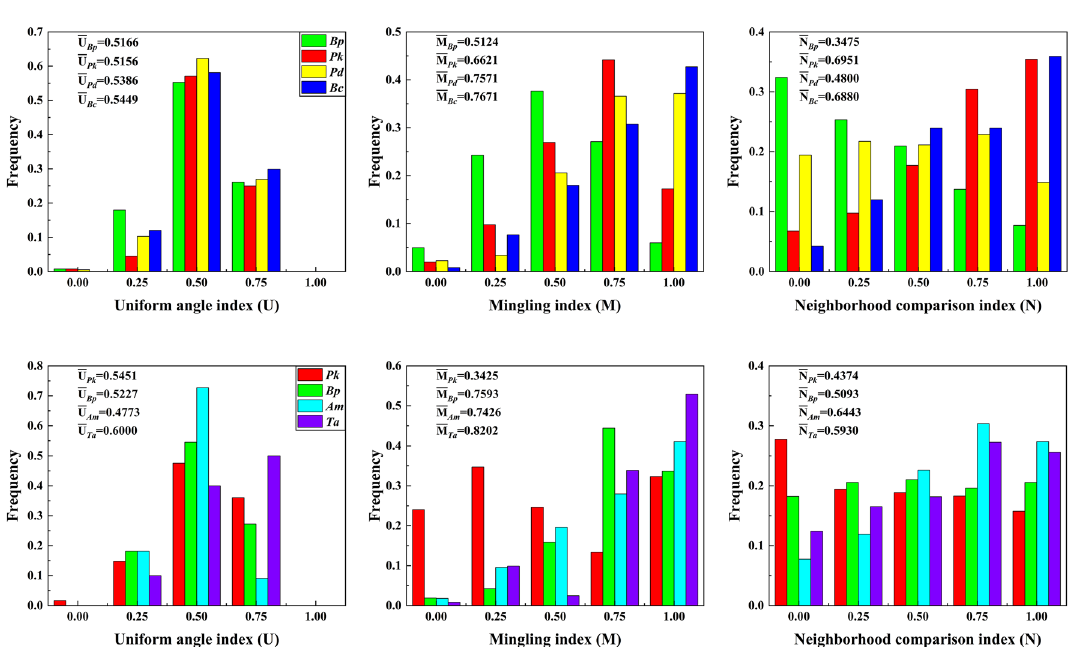
Figure 2. Frequency distribution of the structural indices for dominant species in the disturbed (above) and undisturbed (below)